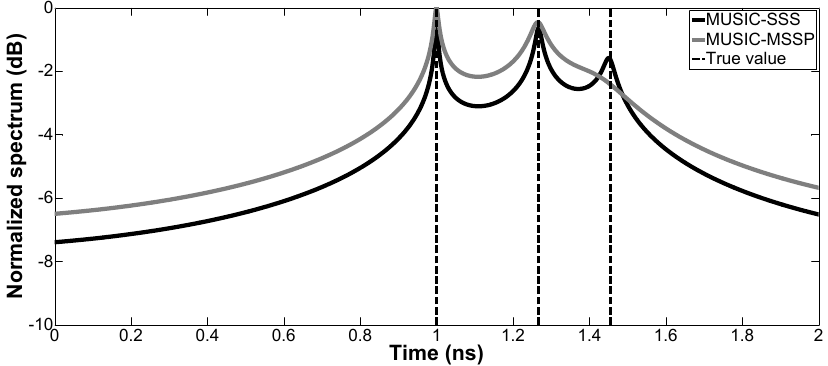
Figure 3. Case b, pseudo-spectrum of MUSIC-SSS and MUSIC-MSSP for TDE with SNR = 10